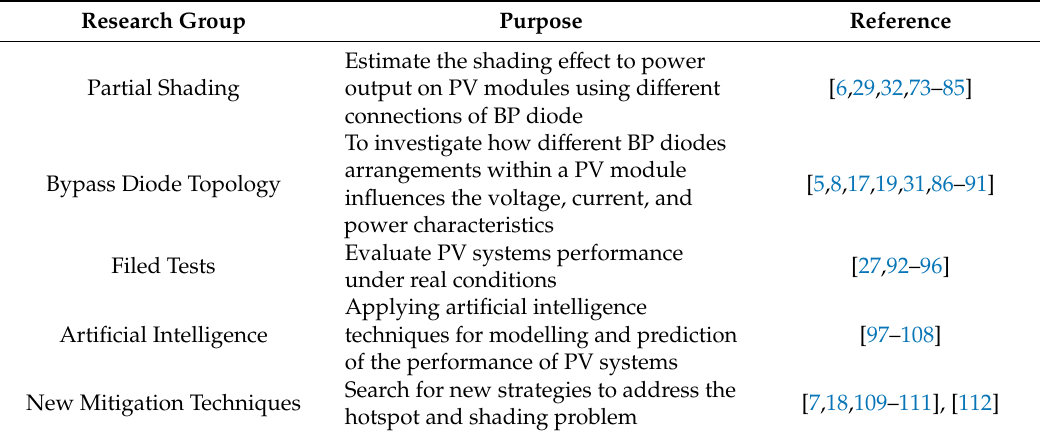
Table 1. Classification of reference by specific